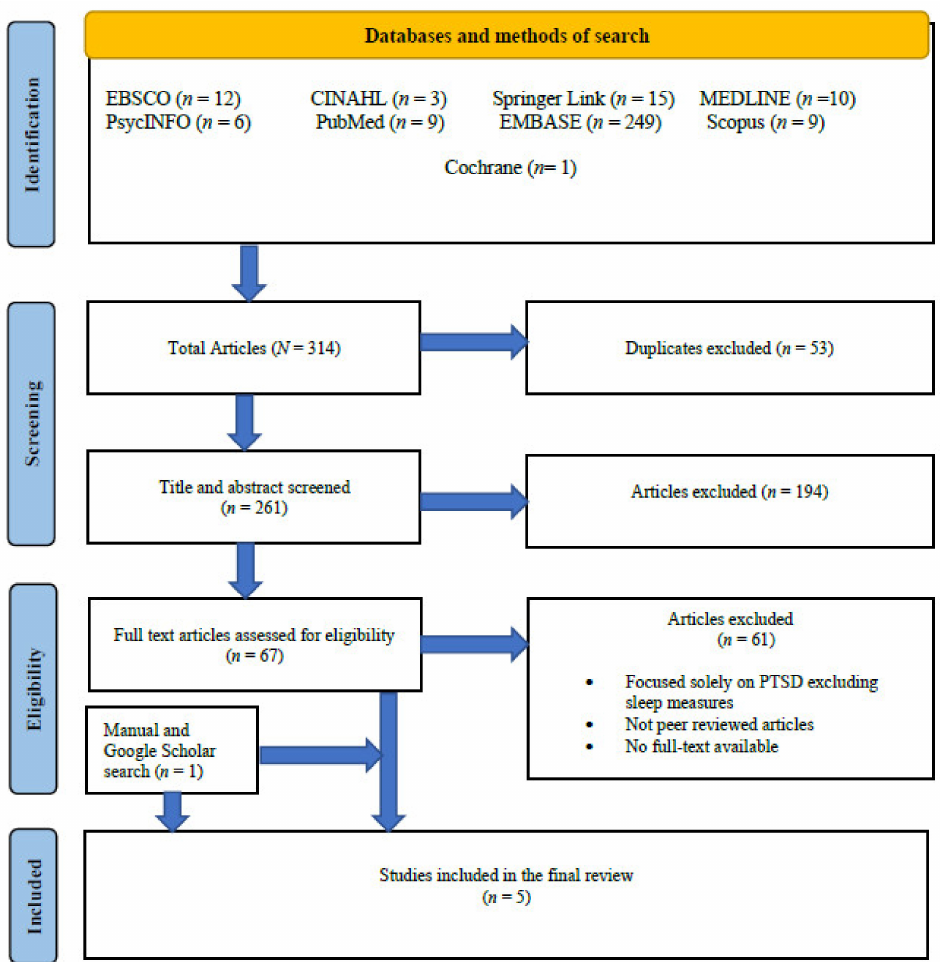
Figure 1. PRISMA flow diagram of the databases search and selection of final